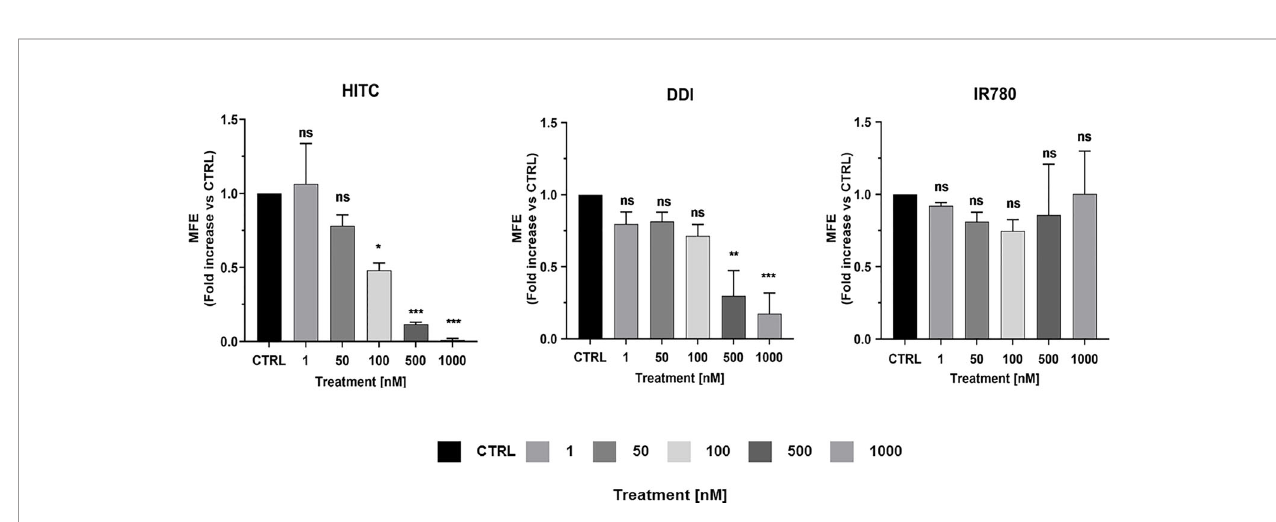
FIGURE 9 | HITC and DDI behave as cancer stem cell inhibitors. Non-adherent MCF7 cells were treated using different drug concentrations of HITC, DDI and IR780 (1, 50, 100, 500, 1,000 nM) for fi ve days and then mammospheres were counted. Data are expressed as fold increase Vs control. Statistical analysis was conducted using one-way